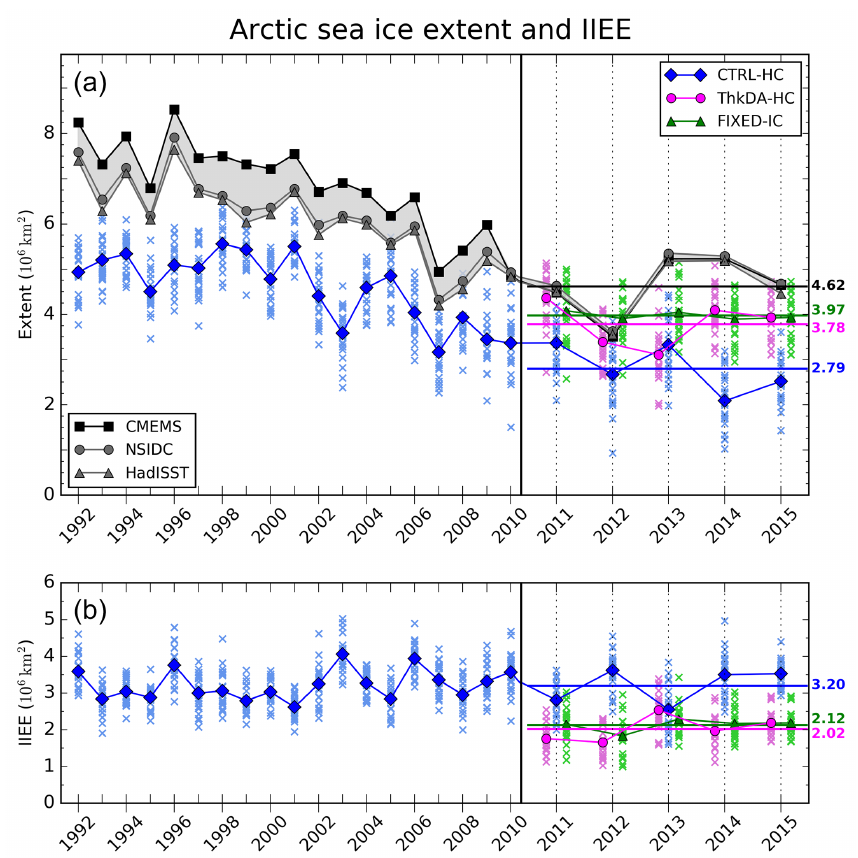
Figure 4. (a) September-mean Arctic sea ice extent from the CTRL-HC (blue), ThkDA-HC (pink), and FIXED-IC (green) seasonal pre- diction experiments. Observational estimates from the CMEMS reanalysis assimilating OSI-SAF (black squares), NSIDC (grey circles) and HadISST1.2 (grey triangles) are included and the area between them shaded light grey. (b) Integrated ice edge error (IIEE) for seasonal predictions relative to the CMEMS reanalysis product introduced in Sect. 2.3. In both panels, individual ensemble members are represented by coloured crosses and ensemble means by the solid symbols and inter-connecting lines. Horizontal coloured lines depict 2011–2015 mean values. For ease of viewing, the ThkDA-HC (pink) and FIXED-IC (green) experiments are plotted with a small offset relative to the CTRL- HC (blue) experiment, and the CS2 period (2011–2015) is plotted with an increased x axis scale, approximately twice that for the early period 1992–2010, with the transition indicated by a vertical black